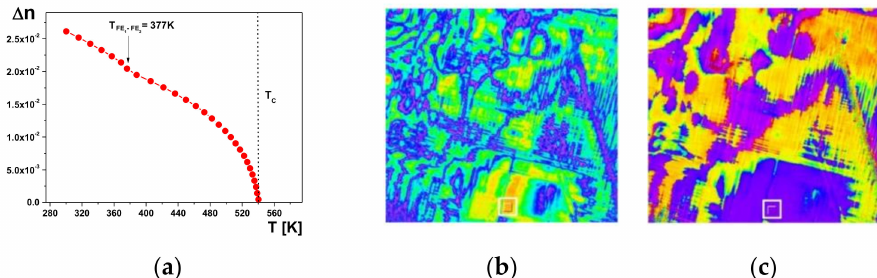
Figure 5. ( a ) Temperature changes of ∆ n (T) in the single PbZ 0.87 Ti 0.13 O 3 crystal. The values of ∆ n were calculated for a region of 25 µ m × 30 µ m which is shown inside the white square in ( b ) and ( c ); ( b ) maps of birefringence at 540 K are also a proof of complex domain structure of the investigated crystal. Di ff erent colors correspond to di ff erent domains with di ff erent orientations of optical indicatrix; ( c ) optical indicatrix orientations at 540 K. This region has been chosen in order to be within the domain of defined orientation of optic indicatrix.